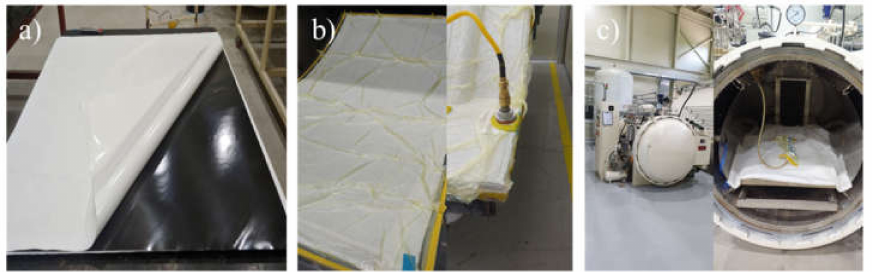
Figure 1. CFRP-preparation process: ( a ) material cutting and lamination, ( b ) vacuum processing, and ( c ) autoclave curing.